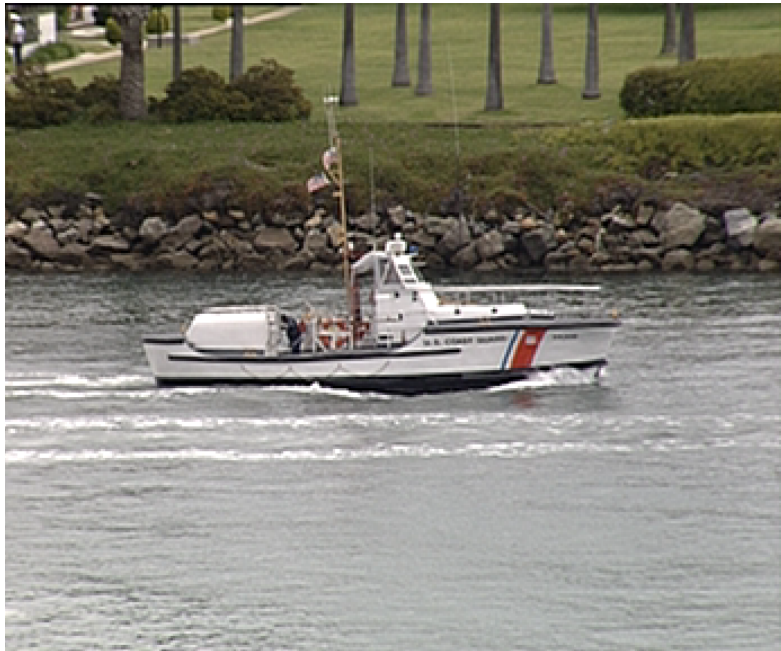
Figure 13. Frame of the original input video.